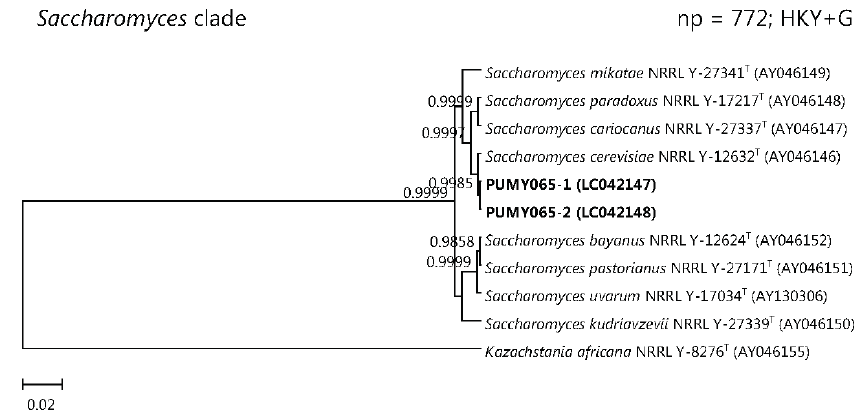
Figure 2. Phylogenetic trees showing the relationship of the six yeast isolates to other members of the Nakaseomyces , Pichia , Lodderomyces-Spathaspora , or Saccharomyces clades. The trees were inferred from ITS sequence data by the Bayesian inference method and the numbers of nucleotide positions (np) of the trimmed, aligned sequences included and the substitution models employed (HKY = Hasegawa-Kishino-Yano model; GTR = general time reversible model; G = γ -distributed rate variation; and I = estimated proportion of invariable sites) for phylogenetic analyses are shown at the top right corner of each tree, and the trees were rooted using Candida castellii NRRL-17070 T , C. silvatica MUCL 29938 T , C. sake CBS 159 T , and Kazachstania africana NRRL Y-8276 T , respectively. The scale bars indicate the estimated numbers of substitutions per base. Numbers at nodes indicate levels of posterior probability support based on the Bayesian analyses of the data sets, and posterior probability values lower than 0.9 are not shown. All accession numbers (in parentheses) are given as cited in the DDBJ/ENA/GenBank databases. The clinical isolates reported in this study are highlighted in bold